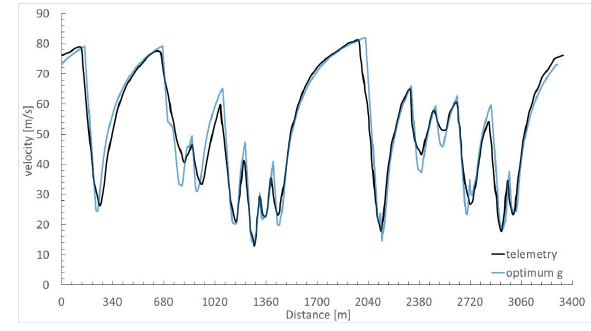
Fig. 1: F1 KERS (ES+MGU-K) and E-BOOST/WHR (ES+MGU-H) from [8] Fig. 2: